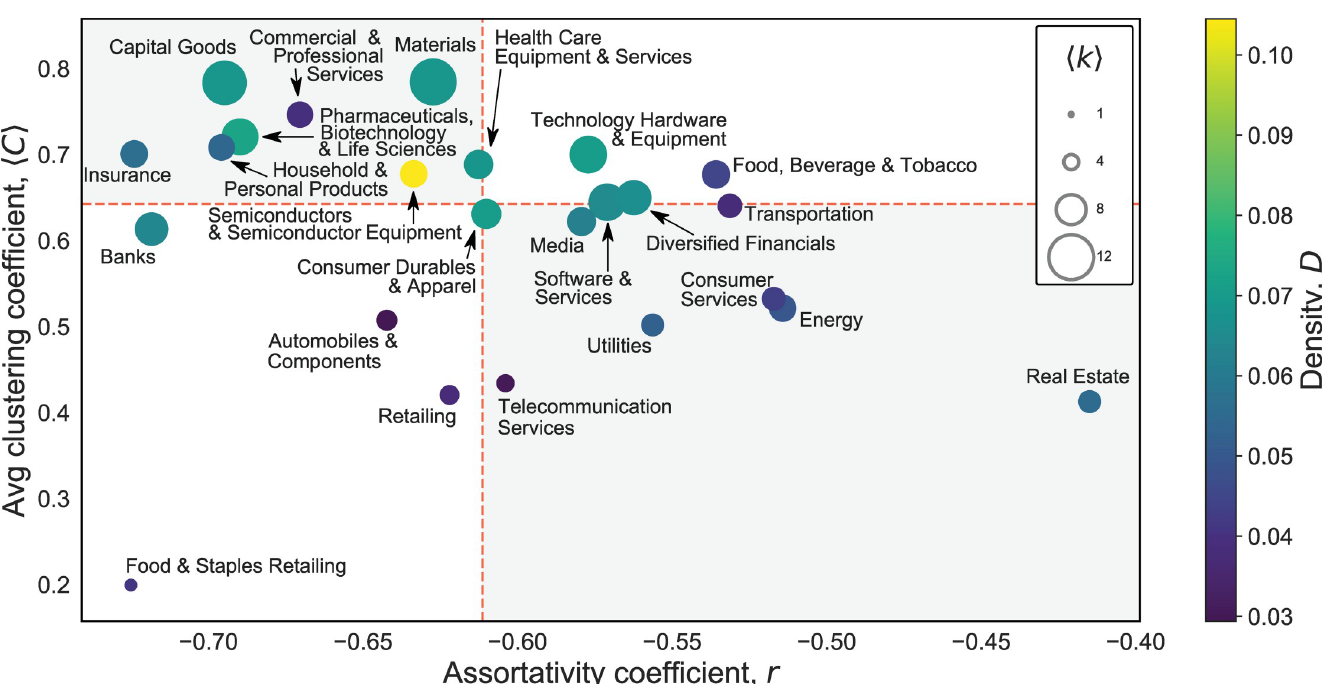
Fig 4. Comparison of D, h C i , r, and h k i of 24 GICS sector networks. Central horizontal and vertical axes represent median values of C and h r i across sectors (0.64 and -0.61, respectively).